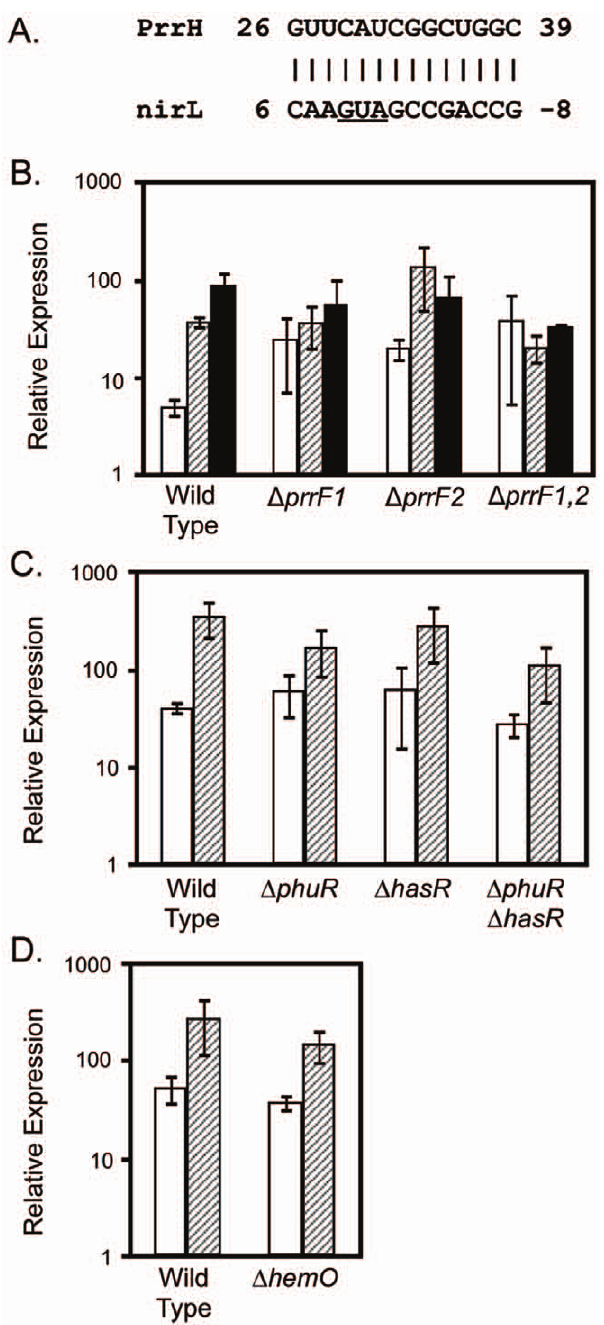
Figure 8. Expression of nirL is activated by heme in a PrrH- dependent manner. A. Complementarity between the PrrH unique sequence, derived from the prrF1-prrF2 intergenic region, and the nirL mRNA. The underlined sequence indicates the start codon for nirL translation. B-C. RNA isolated from wild type PA01 and the (B) prrF , (C) heme receptor, and (D) heme oxygenase mutants, grown for 18 hours in CM9 + 1% glycerol with no added iron (white bars), 40 m M hemin (hatched bars), or 100 m g/ml FeCl 3 (black bars), was used for qRT-PCR as described in the Materials and Method. Error bars represent the standard deviation of expression from three independent